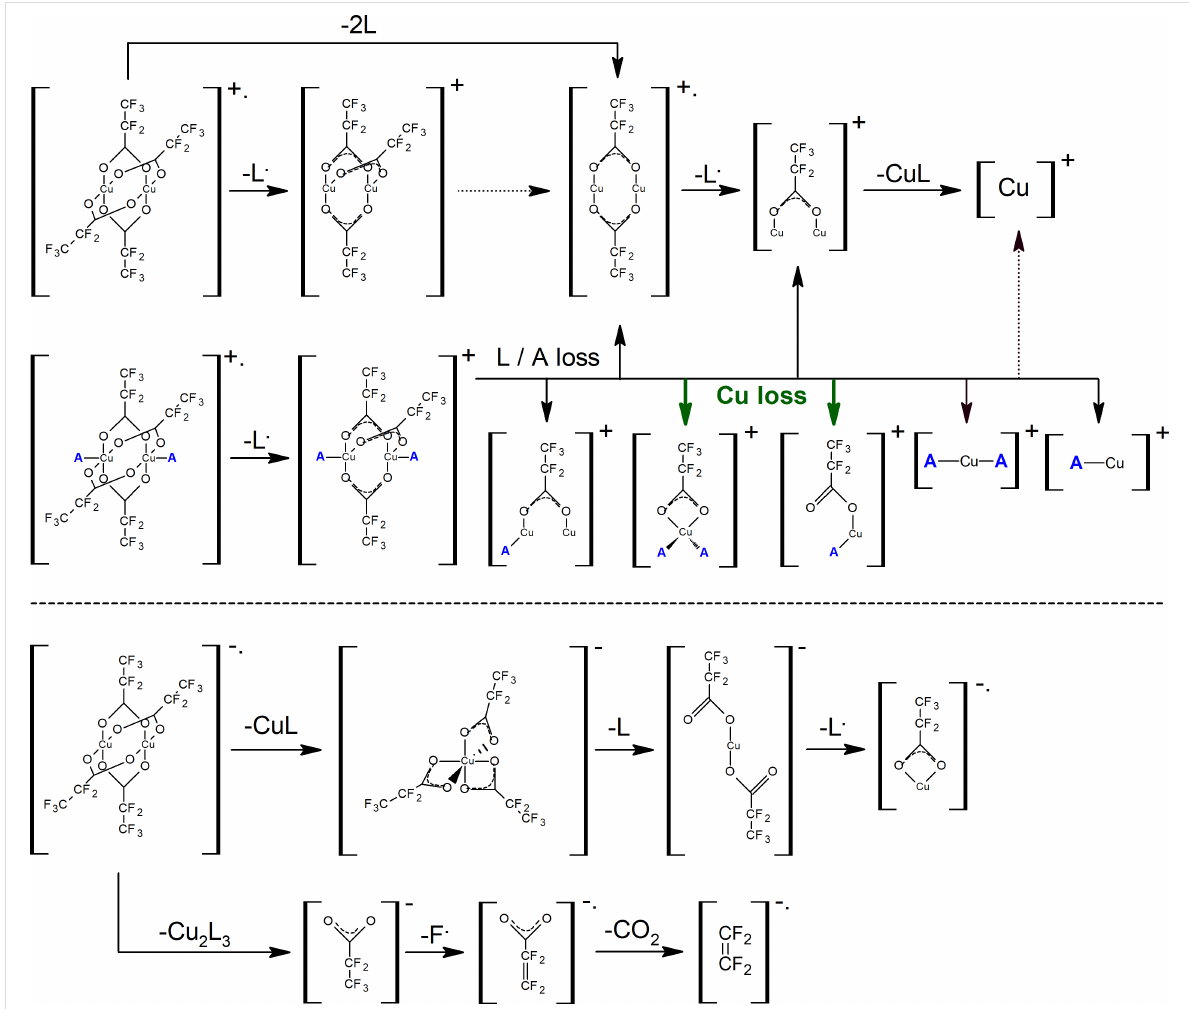
Figure 9: Summary and visualization of the most important ion formation pathways for DI (top) and DEA (bottom).